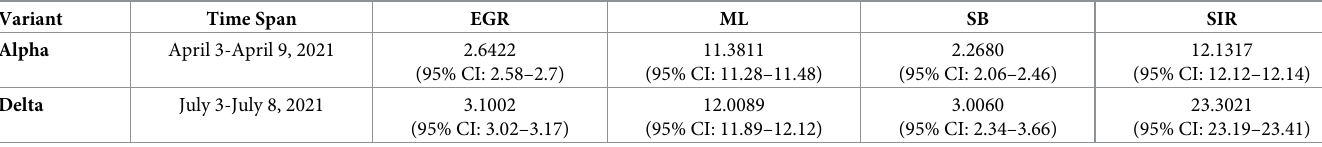
Table 5. Estimated R 0 of Alpha and Delta variants of COVID-19 pandemic in Iran in a time span of exponential growth. Variant